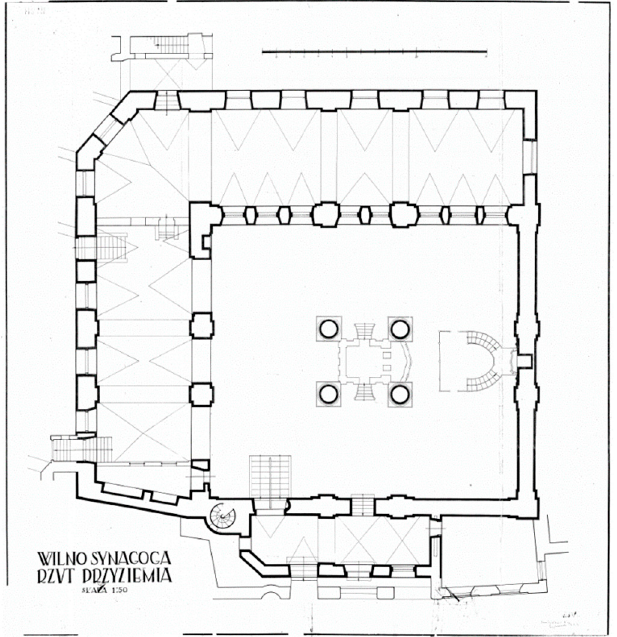
Figure 2. Plan of the Great Synagogue. Drawing: Roman Sigalin and Jerzy Berliner, 1934. Department of Polish Architecture at the Warsaw University of Technology; Used with permission—The Center for Jewish Art, Hebrew University of Jerusalem, ID: